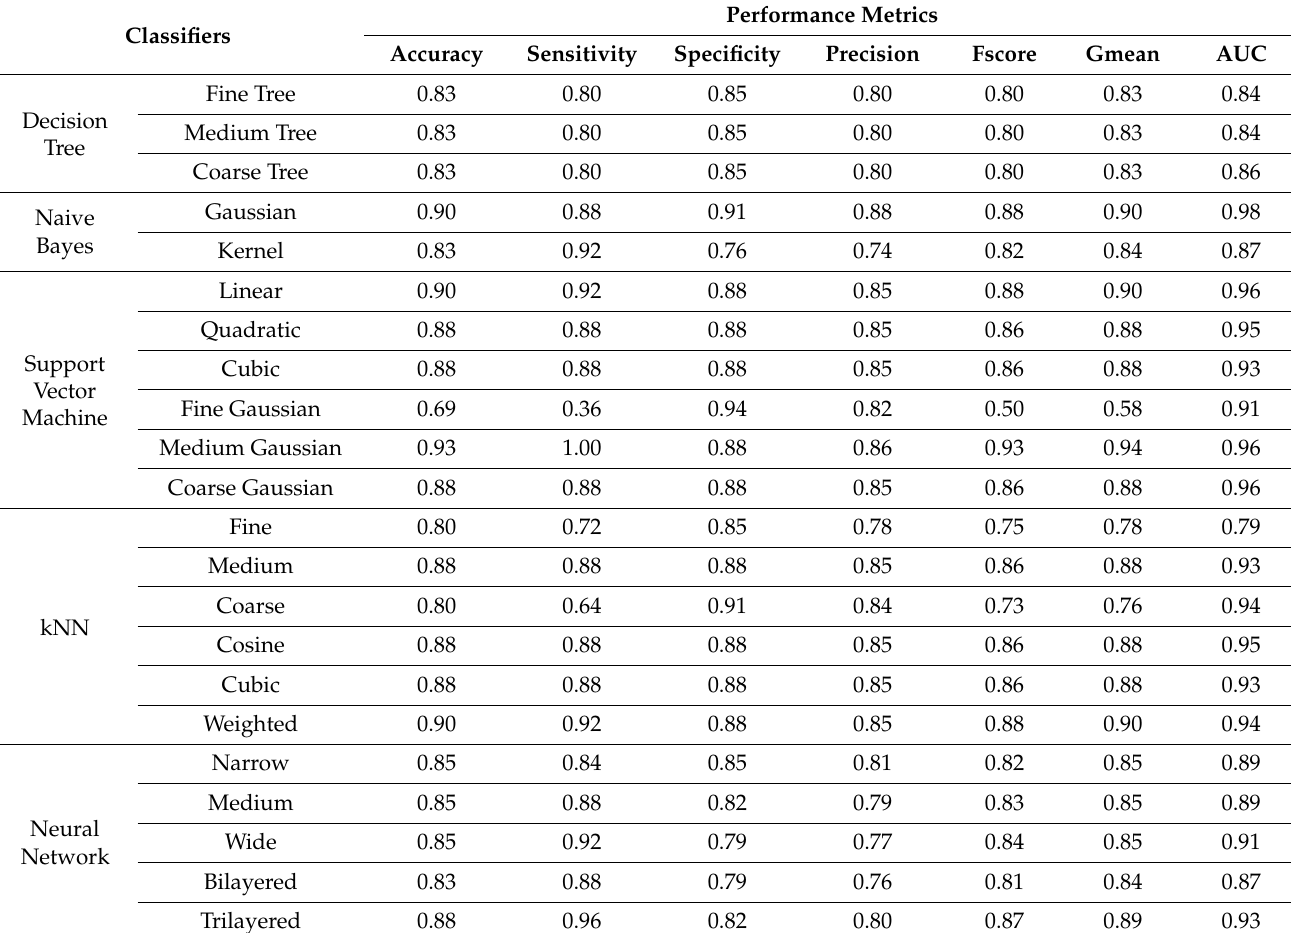
Table 9. Results for the best 75